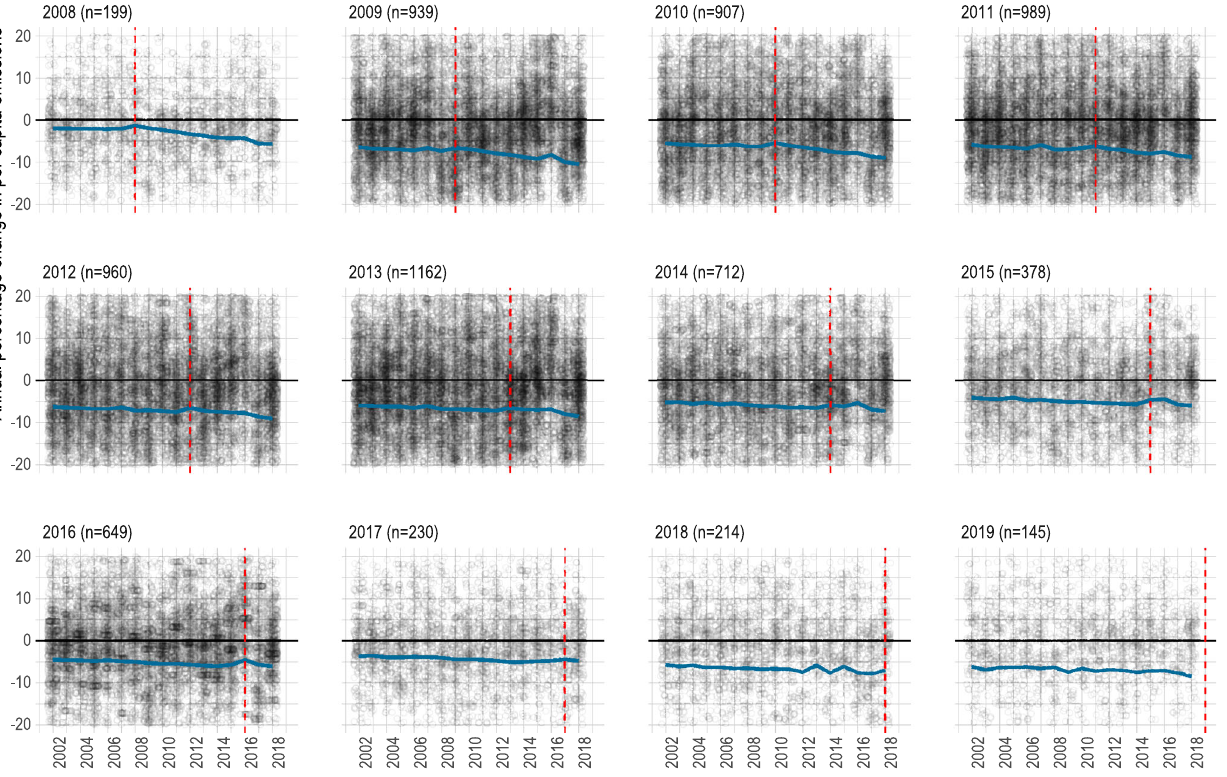
Fig. 4 | Effect of participating in the EU Covenant of Mayors for Climate and Energy. Annual percentage per capita change in emissions for EUCoM cities (plotted points) with predicted annual percentage per capita change in emissions